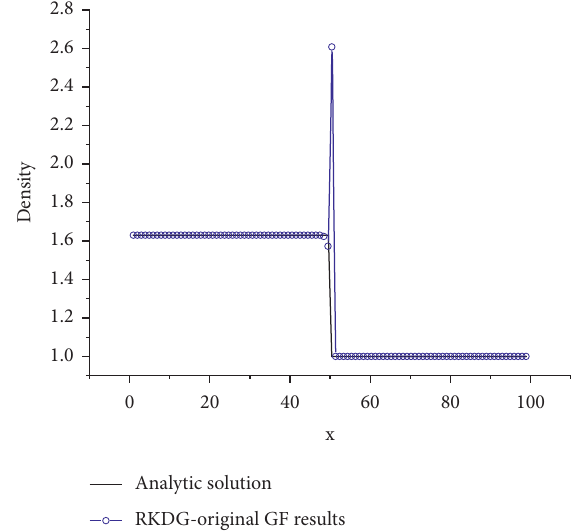
Figure 1: GFM shock tube density overshoot